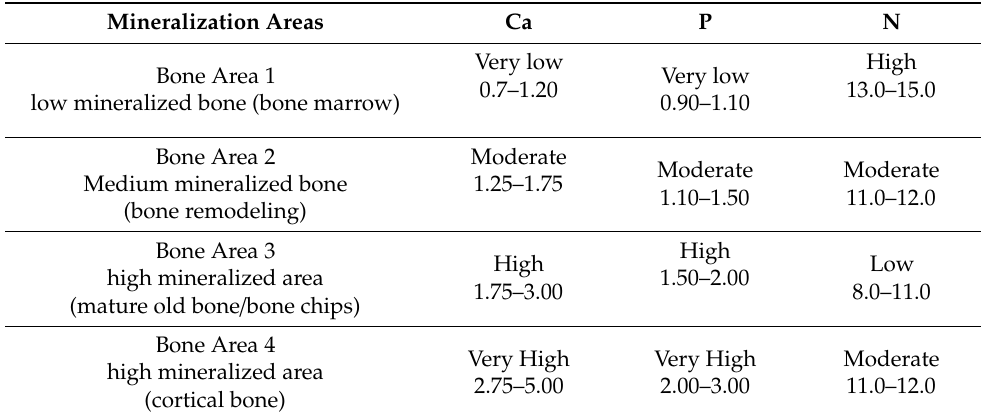
Table 1. Atomic values of Ca, P, and N in the analyzed areas of bone.